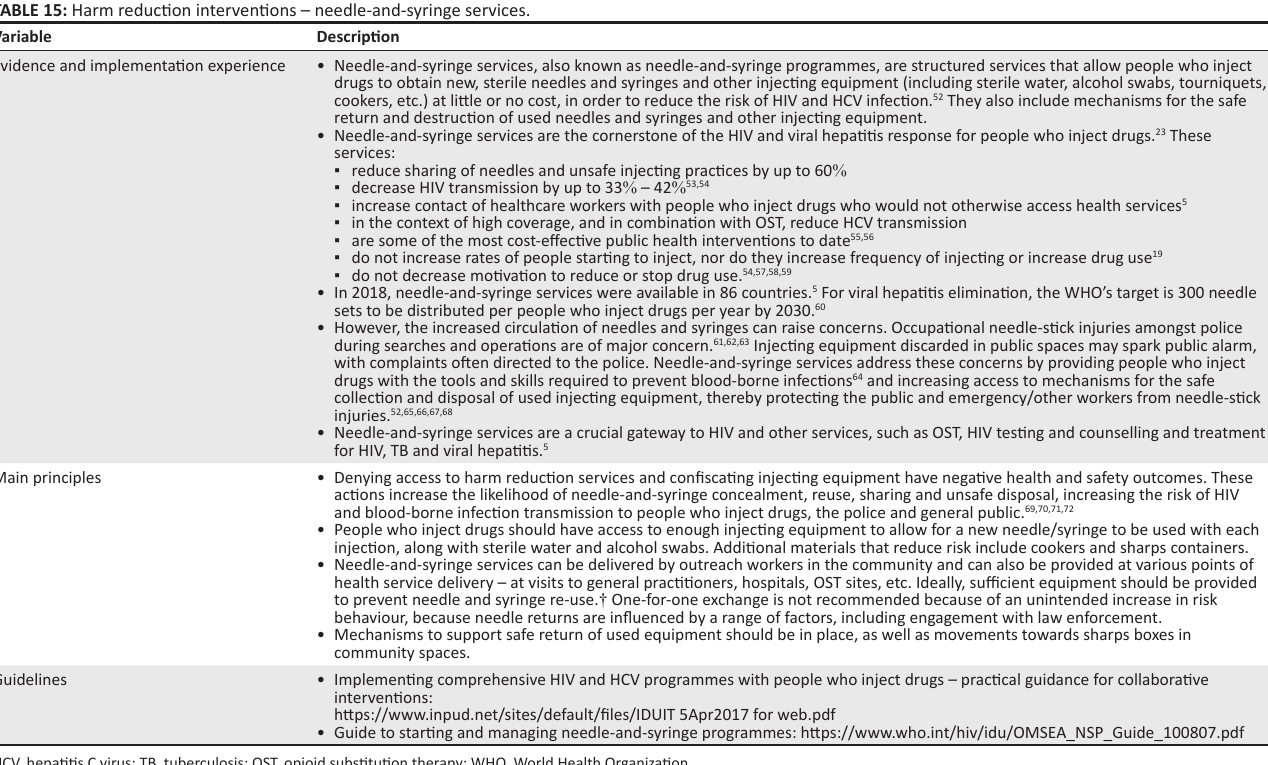
TABLE 15: Harm reduction interventions – needle-and-syringe services.